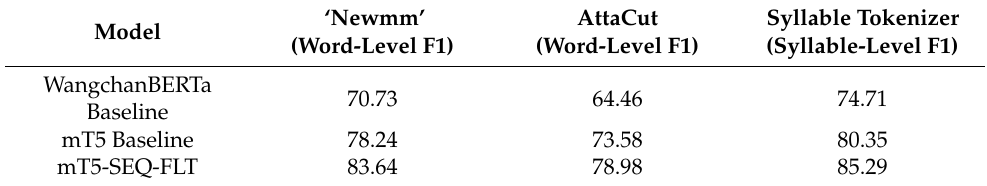
Table 11. The result of Word-level F1 with different types of tokenizers of the Thai Wiki QA